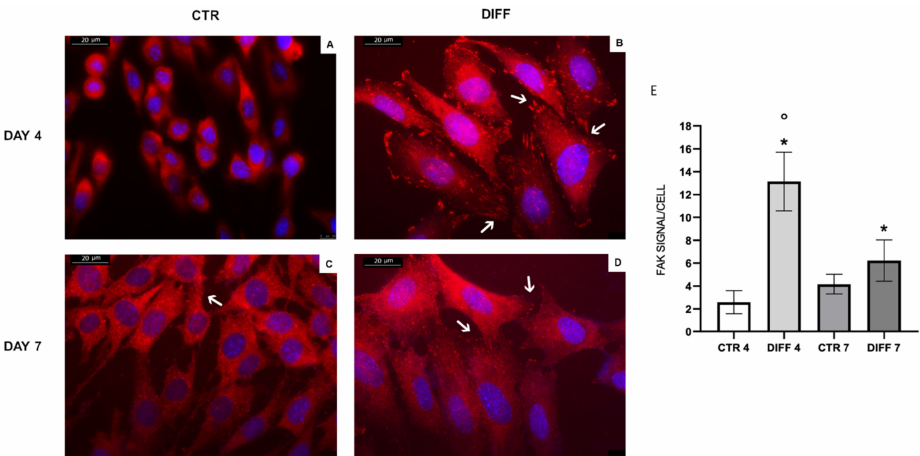
Figure 3. FAK (red) staining in H9c2 cells cultured for 4 and 7 days in growth ( A – C ) and differentiated medium ( B,D ). Nuclei were stained with DAPI (blue). Images are representative of all of the results obtained in the different experimental conditions. White arrows indicate FAK signal in focal adhesions. Scale bar: 20 µ m. ( E ) The number of actin-related FAK-positive signals in each condition is presented in the graph. Statistical significance with respect to the relative controls (* p ≤ 0.05); statistical significance with respect to differentiated cells at day 4 ( ◦ p ≤